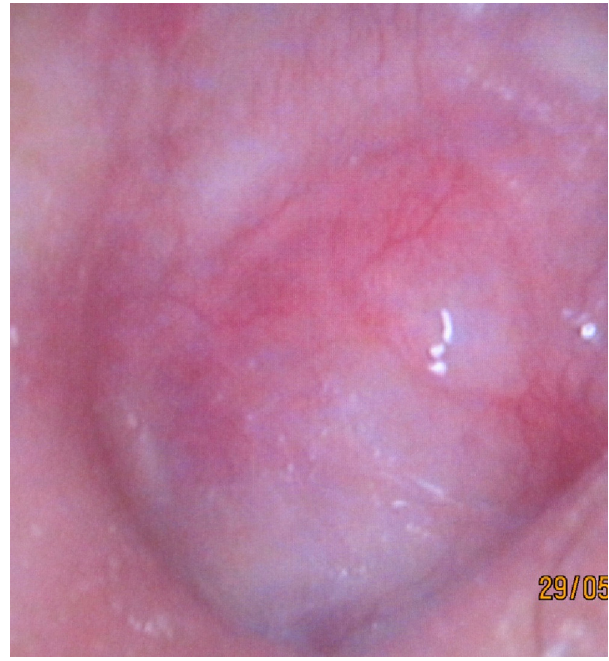
Figure 2 Picture of anatomic result 12 months after the oper- ation.